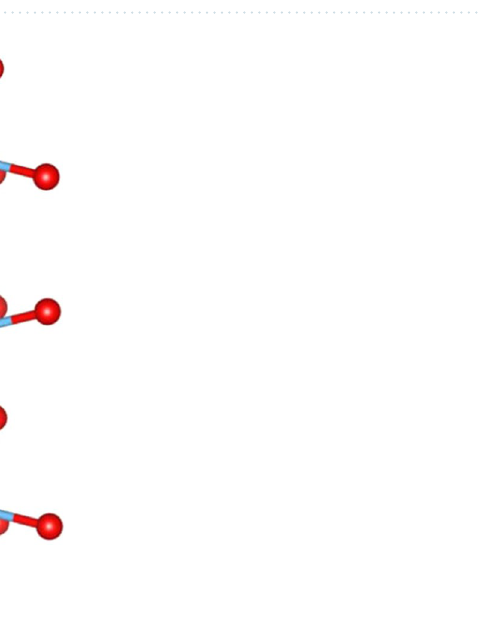
Figure 1. The crystallographic structures of LiNbO 3 (LN)-type ZnTiO 3 (left, space group R3c) and ilmenite (IL)-type ZnTiO